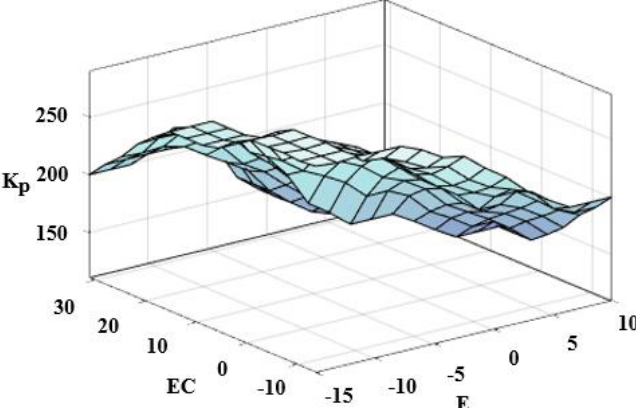
Figure 3. Three-dimensional relationship diagram of the control parameter K p .